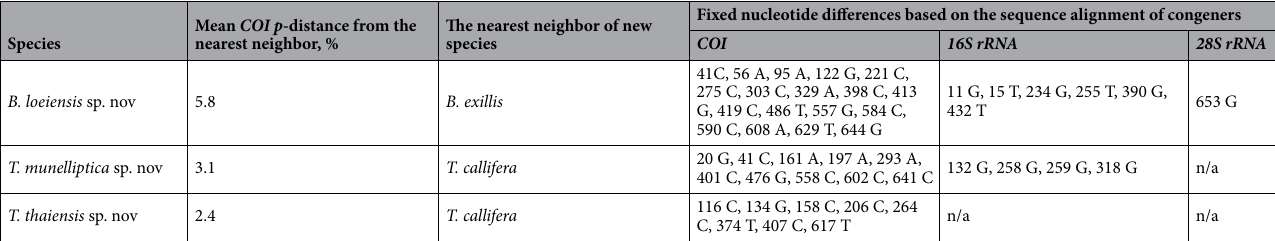
Table 1. Molecular diagnoses of new Bineurus and Thaiconcha species from Mekong and Chao Phraya basins.